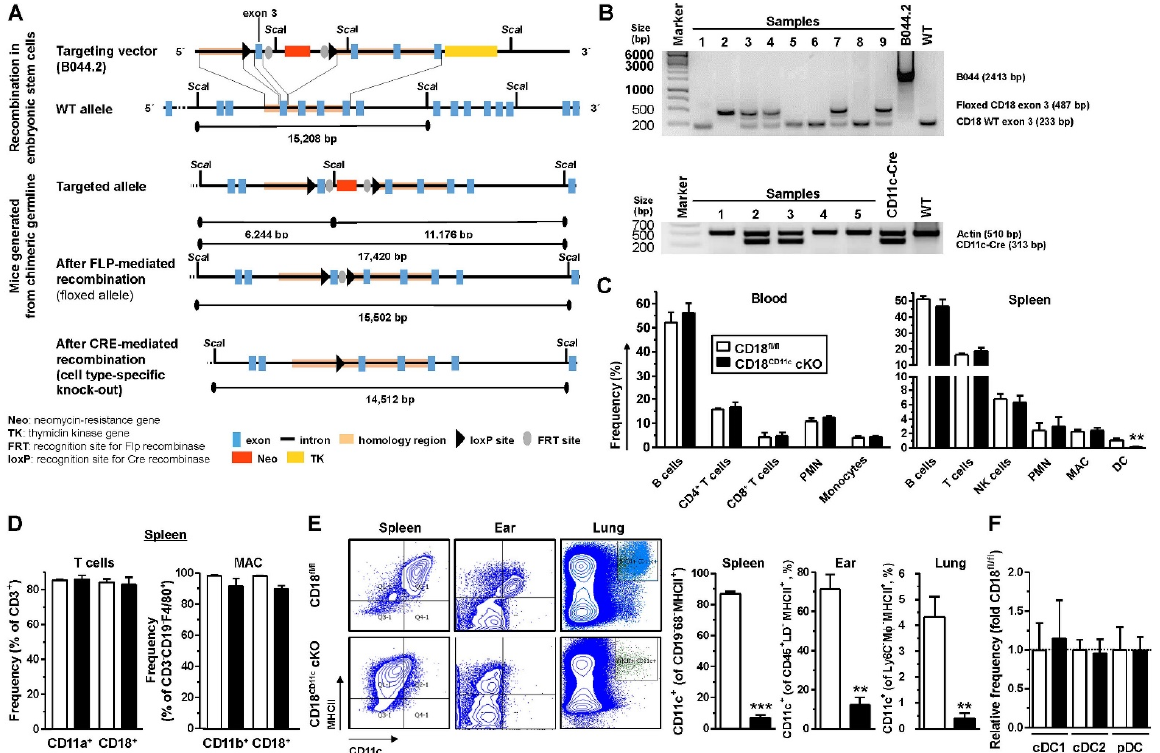
Figure 1. CD18 CD11c cKO mice display a DC-specific knockdown of β 2 integrins. ( A ) Schematic overview of the generation of mice with a floxed CD18 exon 3 gene locus and the Cre recombinase- mediated knockout of exon 3. Sequence information of targeting vector B044.2 are given in Figure S1. ( B ) Examples of PCR-based genotyping of CD18 CD11c cKO mice assessing the presence of the floxed versus wild-type (WT) CD18 allele (upper panel) and Cre recombinase expression (lower panel). ( C ) Frequencies of leukocyte populations in blood (left panel; gating strategy shown in Figure S2) and spleen (right panel; gating strategy as described in [44]) were assessed by flow cytometry (mean ± SEM of 4–6 experiments). ( D ) Frequencies of β 2 integrin α (CD11a and CD11b) and β (CD18) expressing splenic T cells (left panel) and macrophages (MACs) (mean ± SEM of 4 experiments). ( E ) Left panel: Dot plots show expression of MHCII and CD11c in cells derived from different organs and are representative of 3 experiments. Right panel: Quantification of CD11c-expressing cells in different organs (mean ± SEM of 3 experiments). ( F ) Relative frequency of splenic DC populations (gating strategy shown in Figure S4), normalized to the respective control (mean ± SEM of 4 experiments). ( C , E ) Statistical differences versus * CD18 fl/fl are indicated (unpaired t -test) (The asterisk denotes statistical differences between the “knockout” and the control group). ** p < 0.01, *** p <